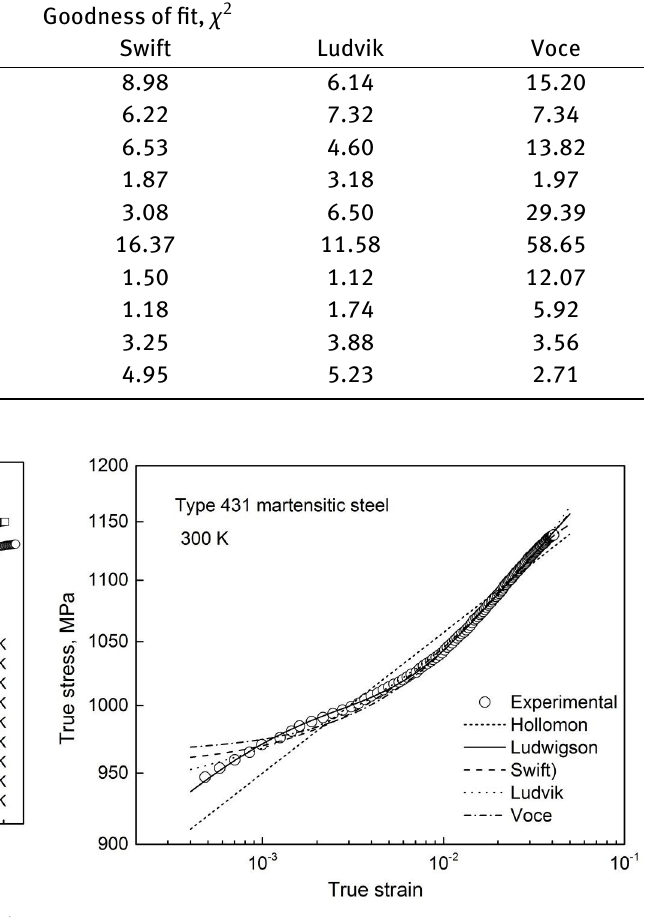
Figure 11: Variation of true stress as a function of true plastic strain for the AISI 431 steel in the temperature range of 300-823 K.